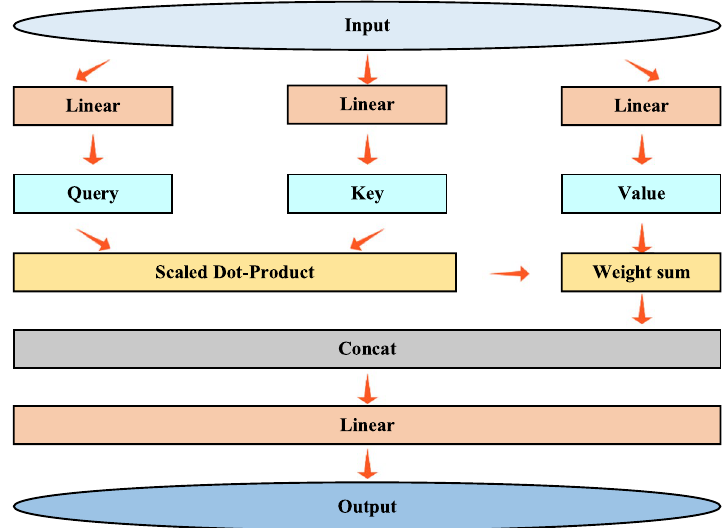
Fig. 5 The multi-head self-attention